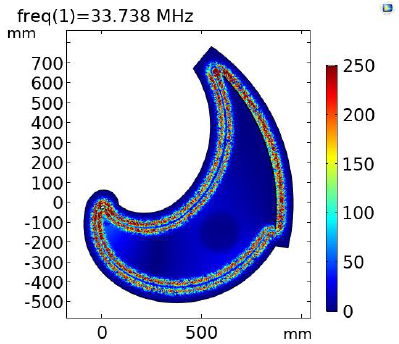
Figure 15. Magnitude of the electric field component E ⊥ orthogonal to the median plane.